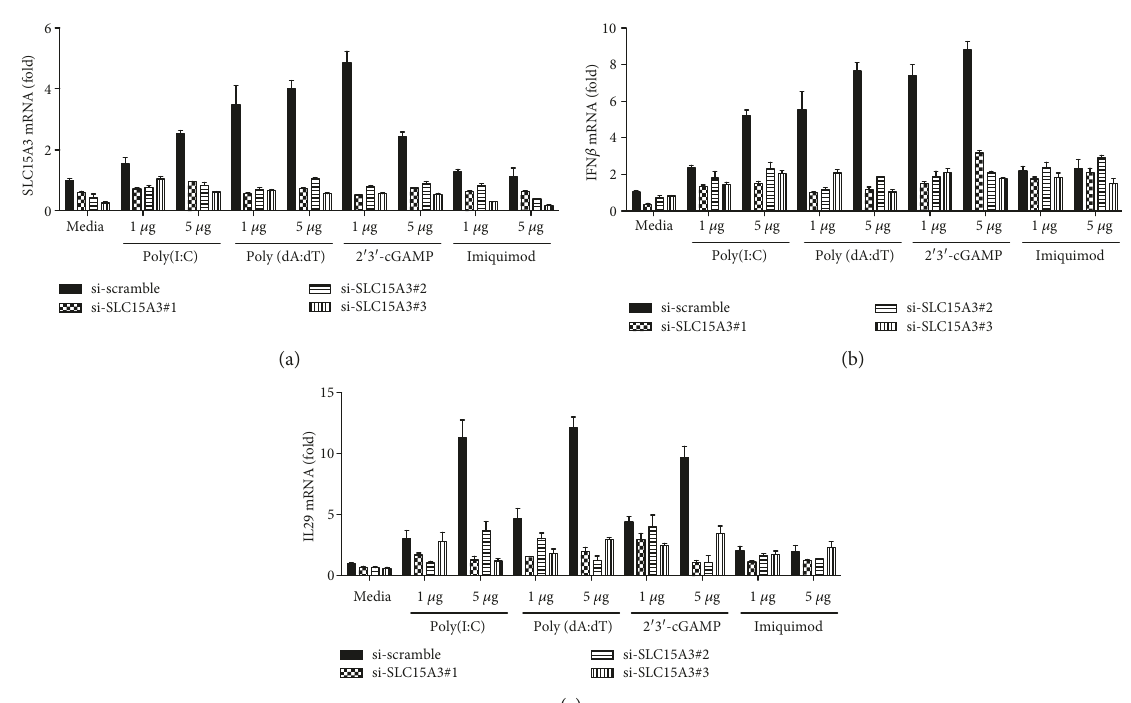
Figure 6: Silencing SLC15A3 in human primary monocytes leads to reduced IFN production by intracellular RNA and DNA agonists. qRT- PCR analysis of (a) SLC15A3, (b) IL29, and (c) IFN β in human primary monocytes transfected with scrambled siRNA and SLC15A3 siRNA for 24 h and then incubated with indicated PRR agonists for 8 h. Data (mean ± sd) are representative of three experiments with similar